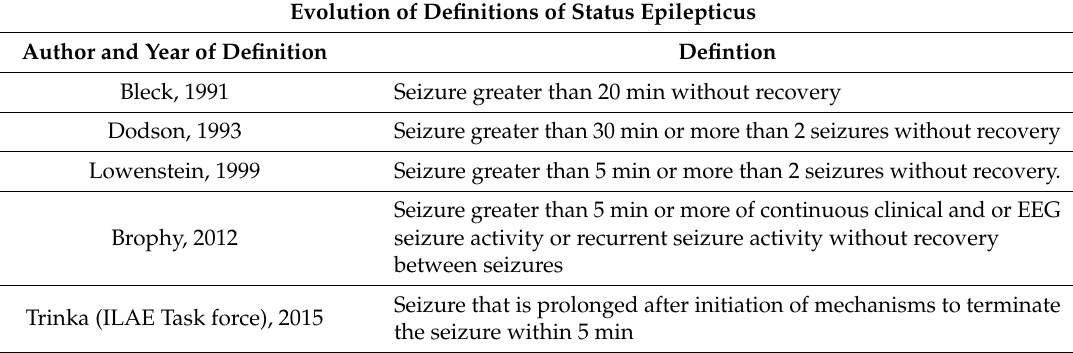
Table 1. Evolution of definitions of status epilepticus